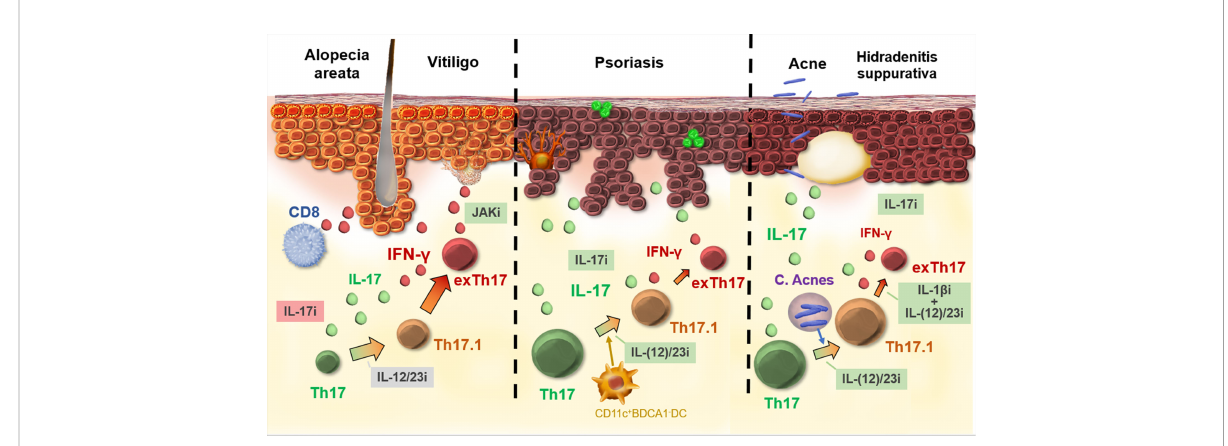
FIGURE 2 Th17 plasticity in skin diseases. In the case ofIFN- g -driven diseases, such as vitiligo and alopecia areata, full transdifferentiation fromTh17 to exTh17 is likely. Biologics acting onTh17 andIL-17 fail to show ef fi cacyfor these disorders. In psoriasis, Th17.1 cells arenot uncommon, althoughexTh17 cells are less important, as illustrated by the high ef fi cacyof biologics acting onTh17/IL-17 and early transdifferentiation [ e . g .,IL-12/23 inhibition(i)]. Acne stimulates the formation ofTh17.1, but exTh17 lymphocytes areless strongly induced. A combinationtreatment (IL-1 b i anti-IL12/23i) is necessaryto block transdifferentiationfromTh17.1 to exTh17. Green boxes, goodef fi cacy; gray boxes, variable ef fi cacy; red boxes, noef fi